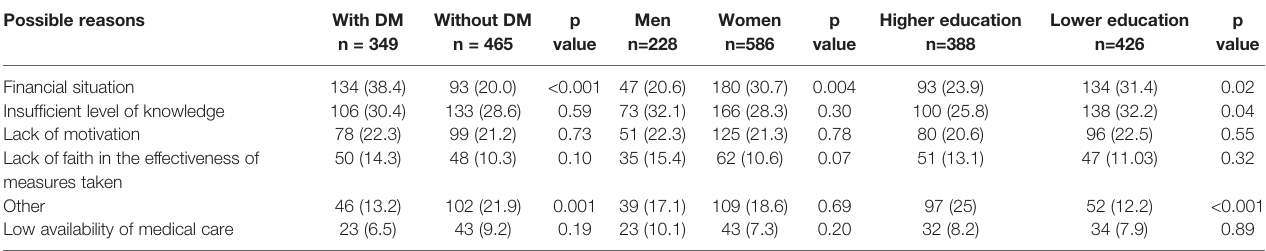
TABLE 3 | Barriers to adherence to healthy lifestyle instructions in the study respondents: comparison by the diagnosis of diabetes, gender, and education. Possible reasons